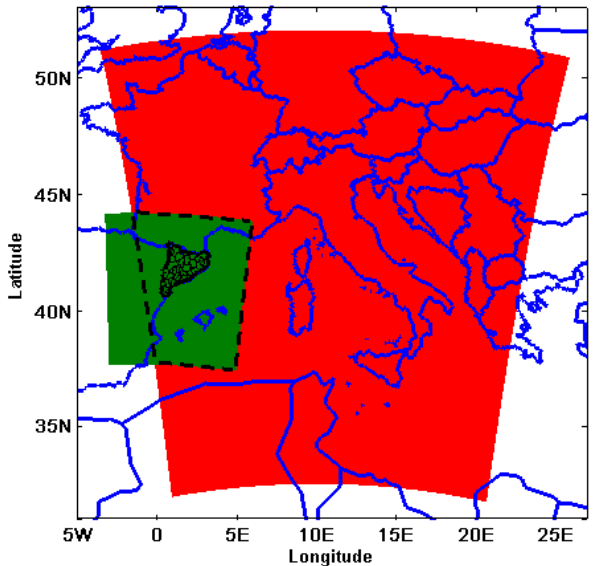
Fig. 1. MM5’s domain (in green) superimposed to COSMO-I7’s (in red). A dashed black line encloses the overlapping area. Catalonia Figure 1. MM5‟s domain (in green) superimposed to COSMO-I7‟s (in red). Dashed 3 and its comarca division is showed in black lines. Figure 2. Location of the 146 automatic rain gauges (red dots) from XEMA network all 3 black line encloses the overlapping area. Catalonia and its comarca division is showed 4 in black lines. 5